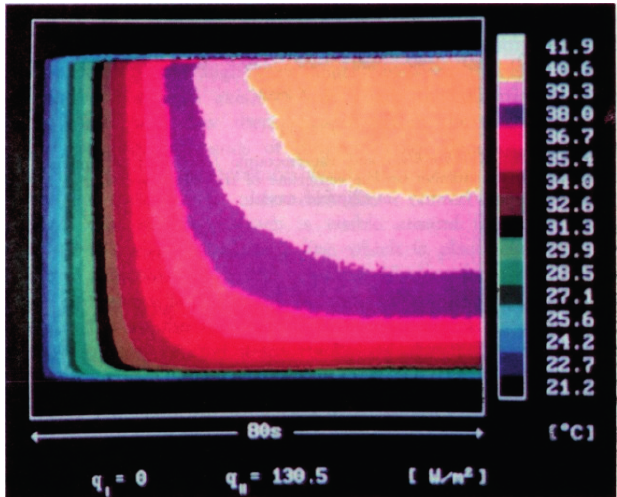
Figure 13. Time evolution of the temperature vertical profile on the foil under transient natural convection. From Carlomagno and de Luca